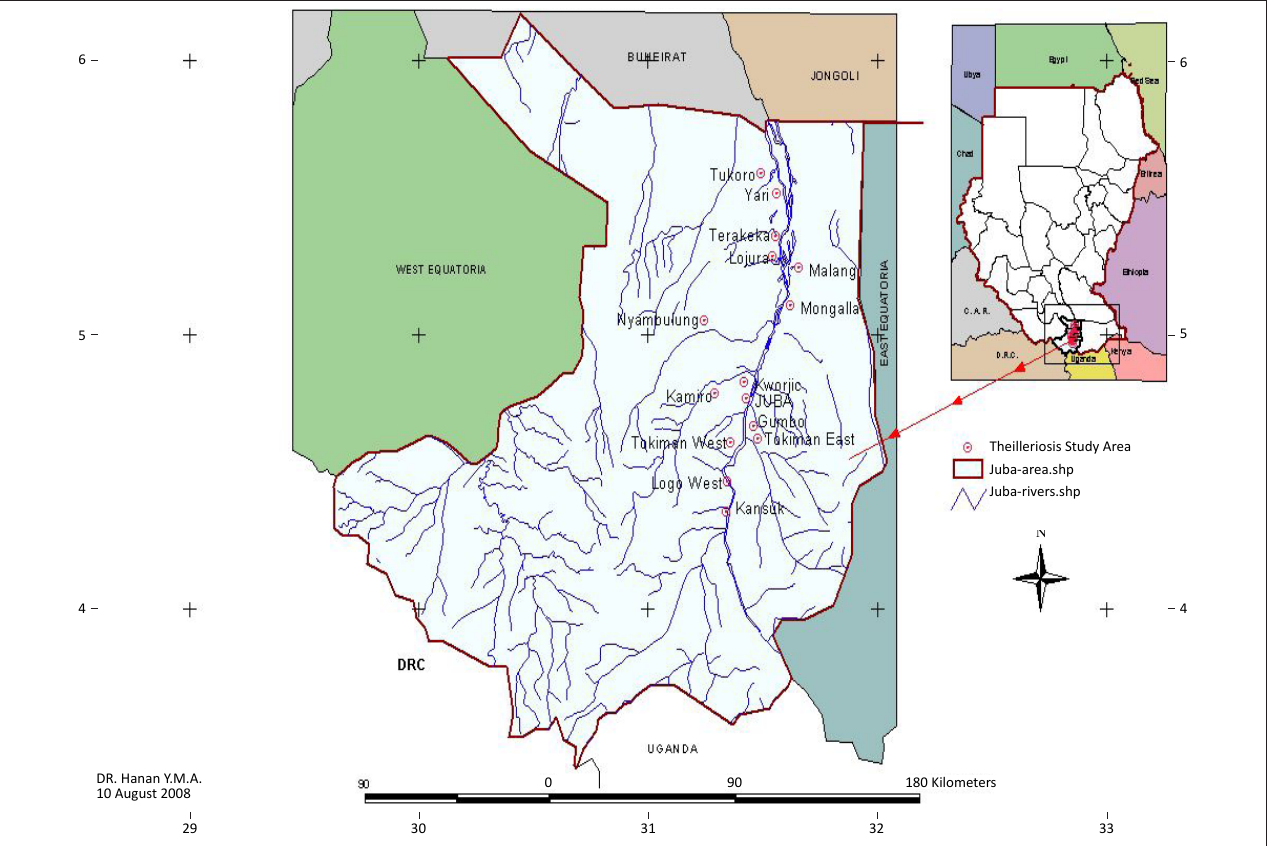
FIGURE 1: The Central Equatoria region of southern Sudan, indicating sampling